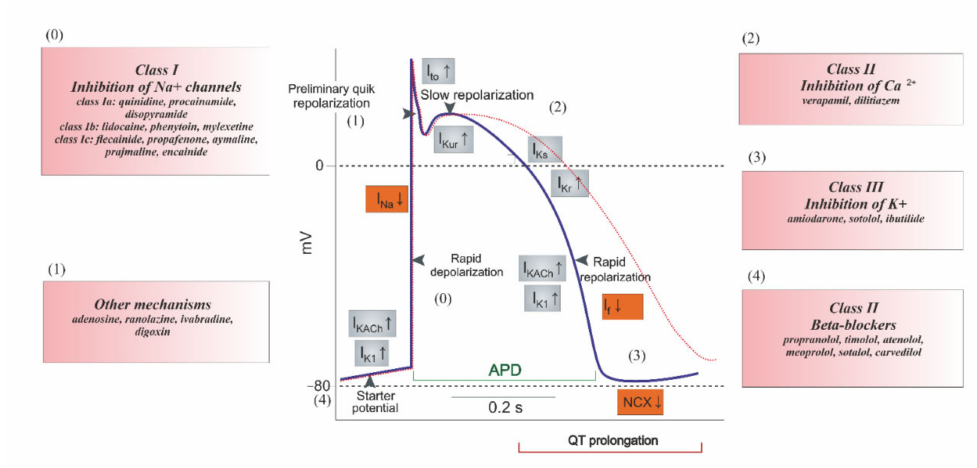
Figure 3. Classification of cardiac antiarrhythmic